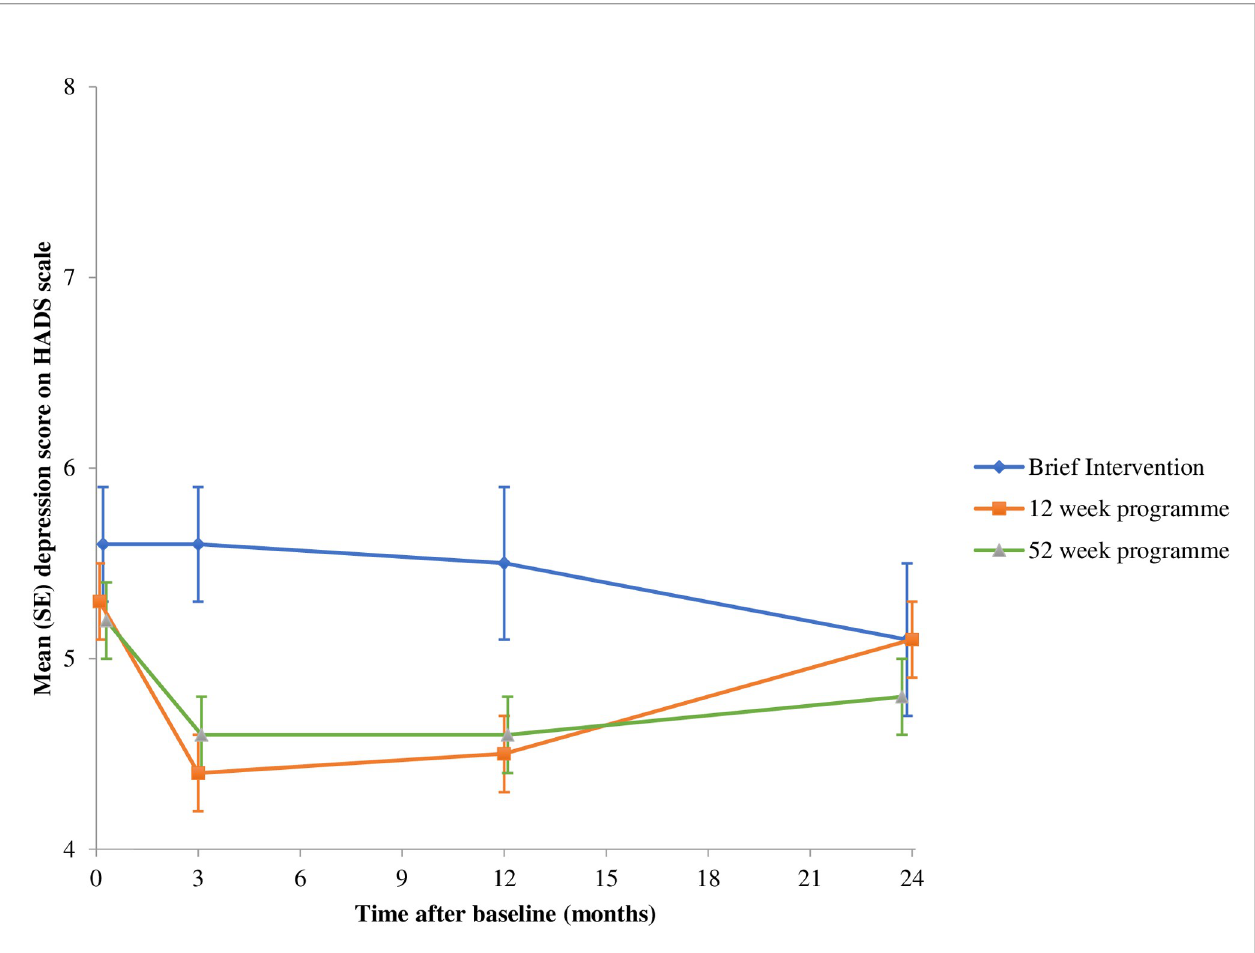
Fig 2. Depression score over 24 months of follow-up. Data are mean (standard error) of all measured HADS at each time point (Table 2).